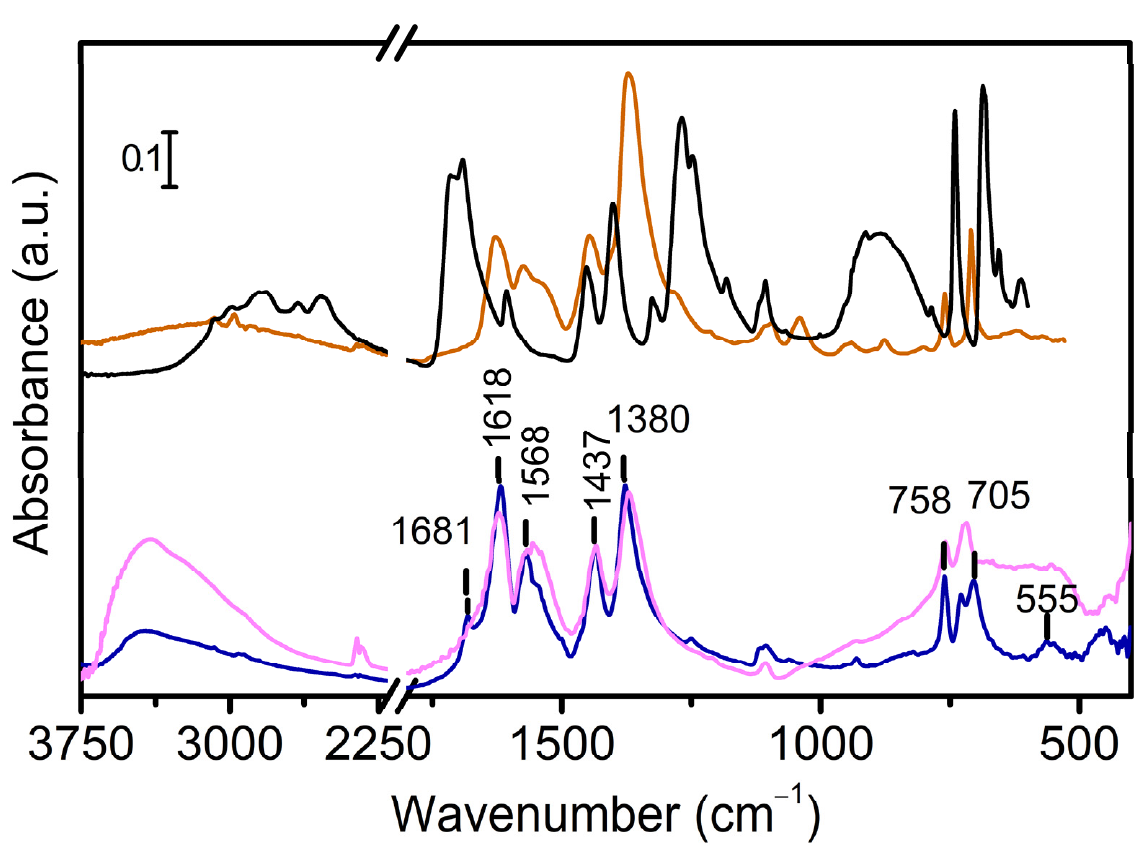
Figure 5. FT-IR spectrum of KCL-102 (blue line) recorded in air right after synthesis compared to the spectrum of KCL-102-air (light pink), trimesic acid (black line), and of another trimesate based MOF (MIL-100(Fe), unpublished data, brown line). For additional characterization of this MIL-100(Fe) sample, please refer to Ref. [57].